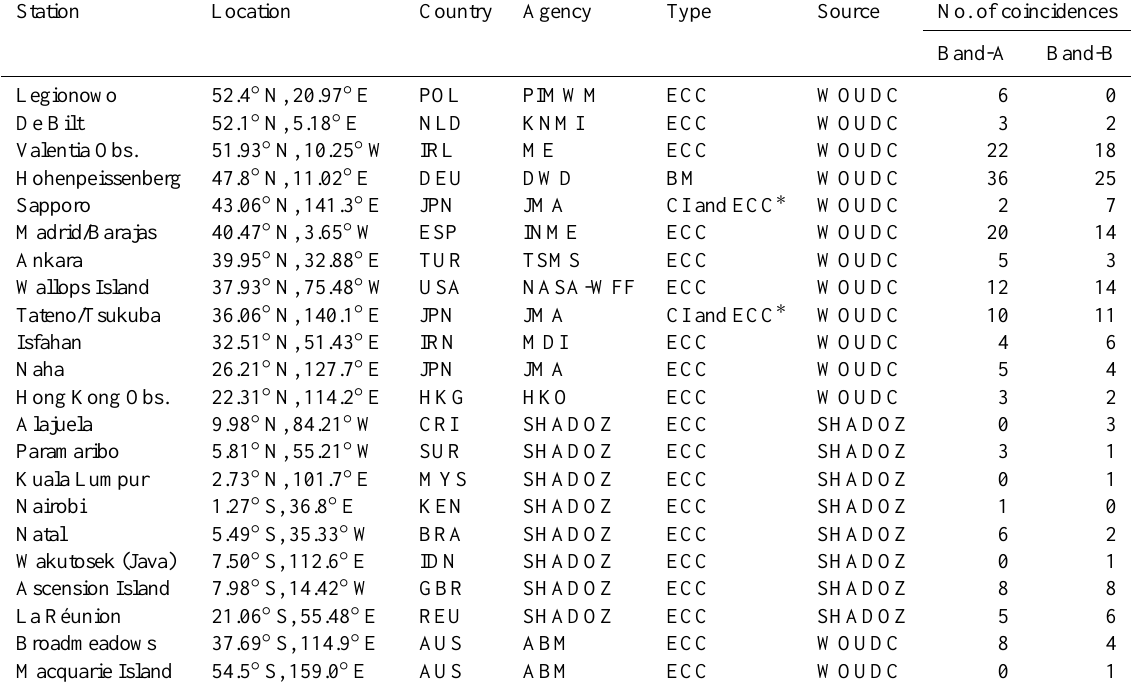
Table 5. Summary of the ozonesonde stations used in the presented comparison. Station